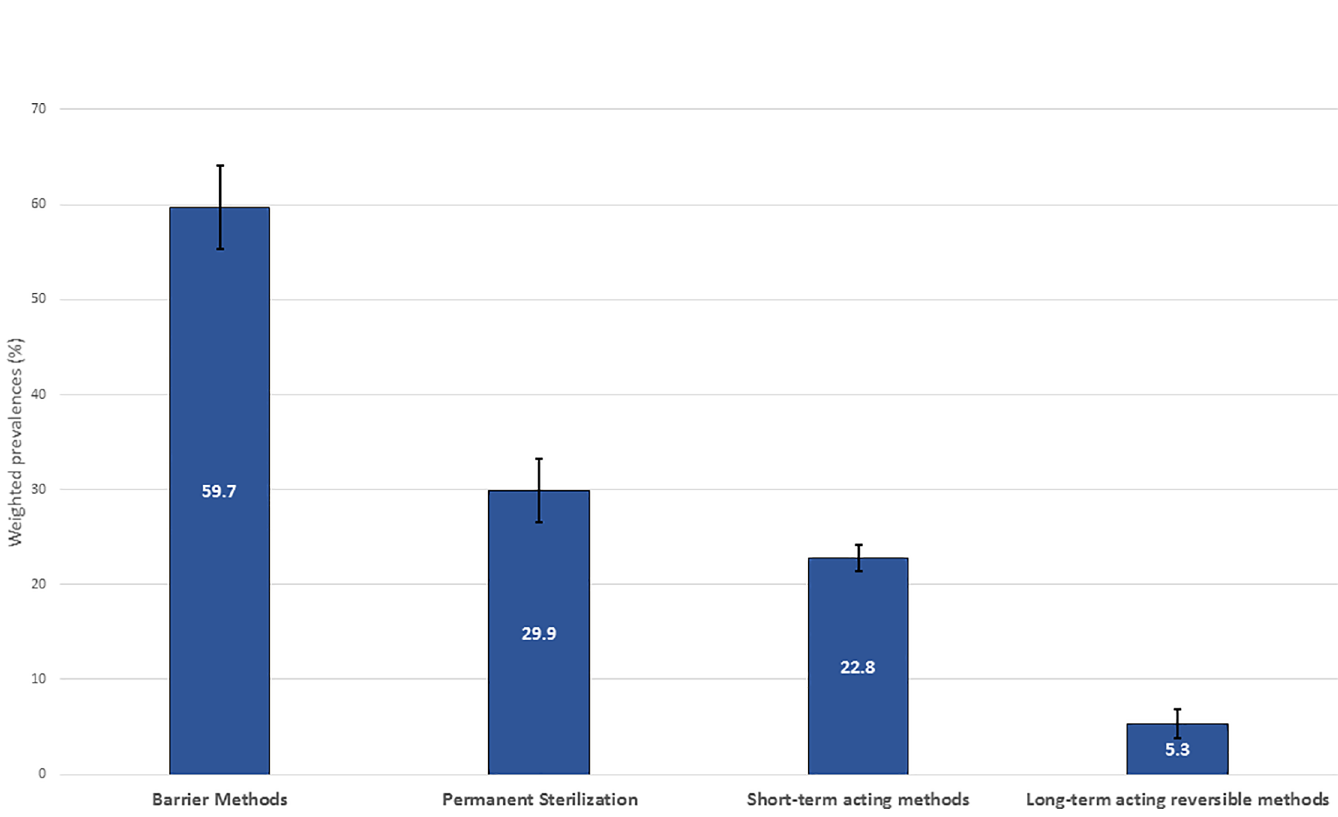
Fig 2. (cid:3) Contraceptive use among HIV-positive women in HIV care aged 18–44 years, Medical Monitoring Project, 2013–2014 (n = 957). (cid:3) Footnote: Methods may have been selected more than once. Graph excludes women who were not able to become pregnant due to hysterectomy and those who were abstinent.